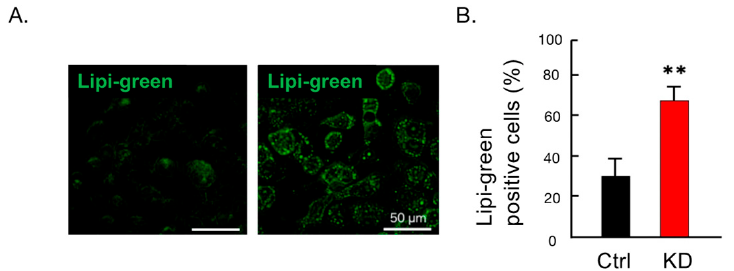
Figure 4. Increased fat accumulation in IARS1-KD HepG2. ( A , B ) Palmitic-acid-stimulated intra- cellular accumulation of fat droplets was significantly higher in IARS1-KD cells ( n = 3); ** denotes p <